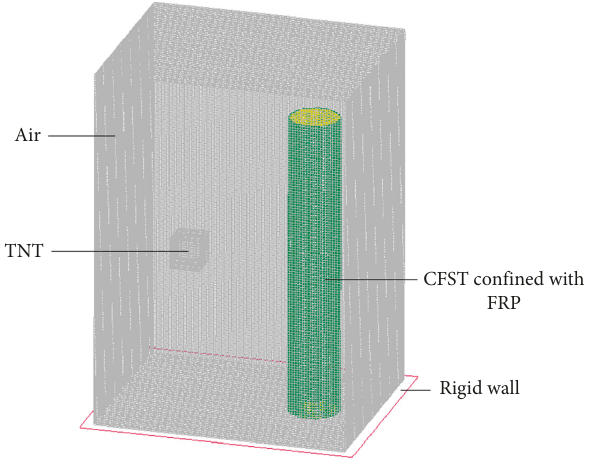
Figure 3: 3D finite element model. Table 1: Variables of